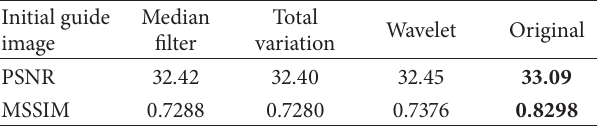
Table1:Effectofinitialguideimagewith50%salt-and-peppernoise in Barbara